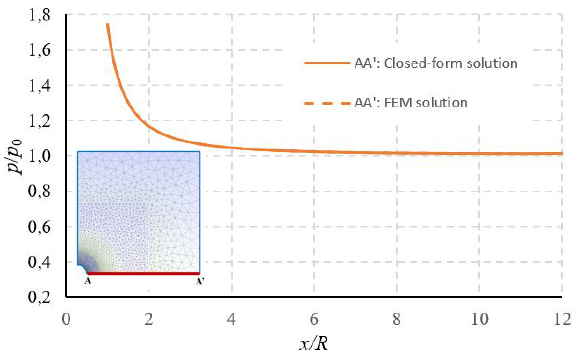
Fig. 6. Volumetric strain at two points A ( θ = 0 or π ) and B ( θ = π /2 or 3 π /2)